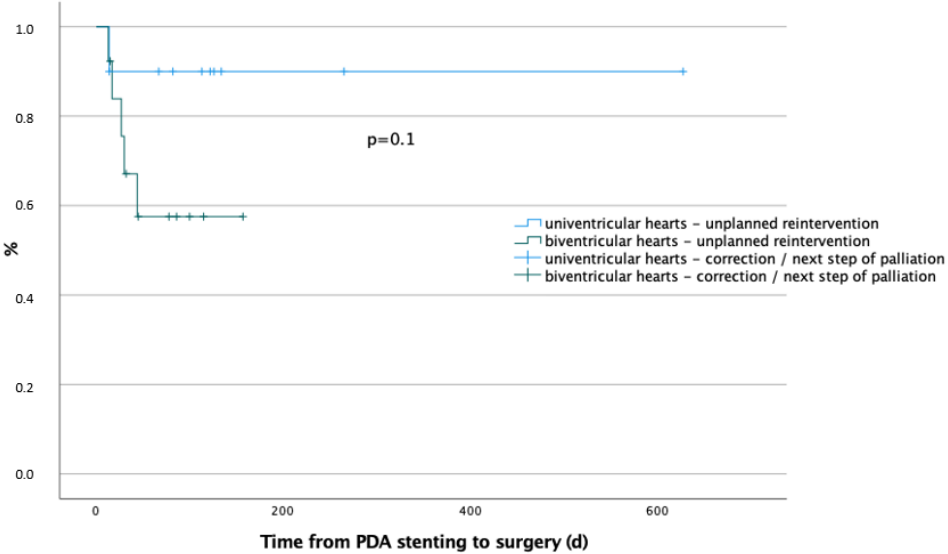
Figure 4. Kaplan–Meier curve comparing freedom from re-intervention in anticipated univentricular (blue) or biventricular (green) physiology ( p = 0.1). There was no difference between the two groups.